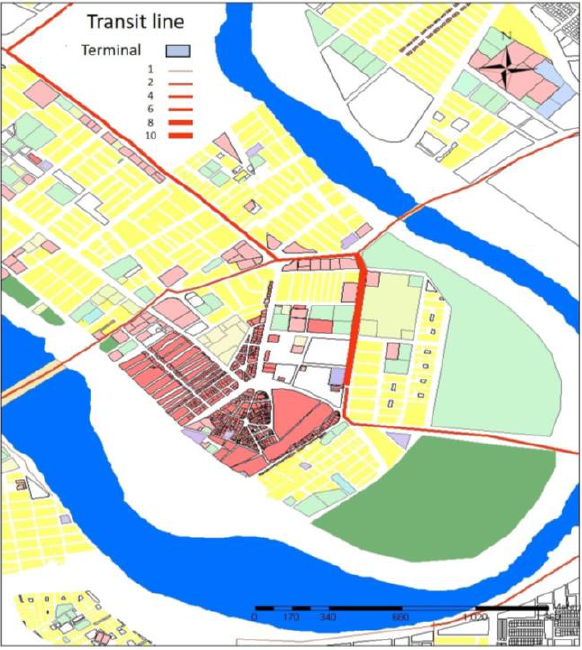
Fig. 3. Roads network in the city centre